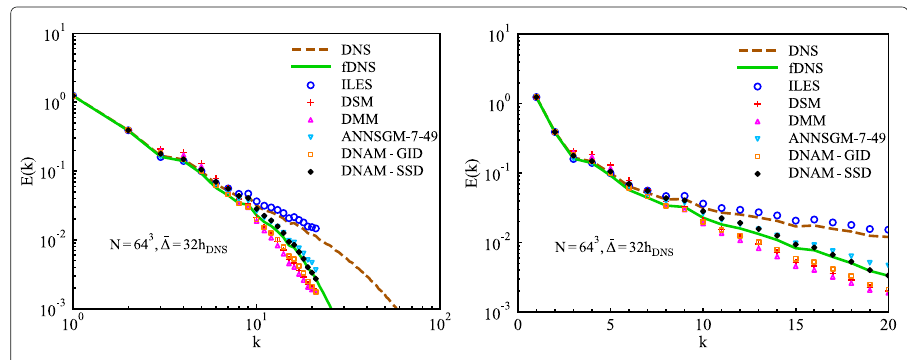
Fig. 6 Velocity spectra in aposteriori study at filter scale 32 h DNS